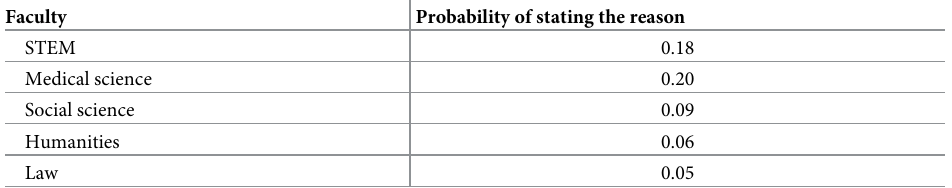
Table 12. Share of PhD students (predicted probabilities) who granted a guest authorship because “Everyone else in my field does it” ( n = 1,096).